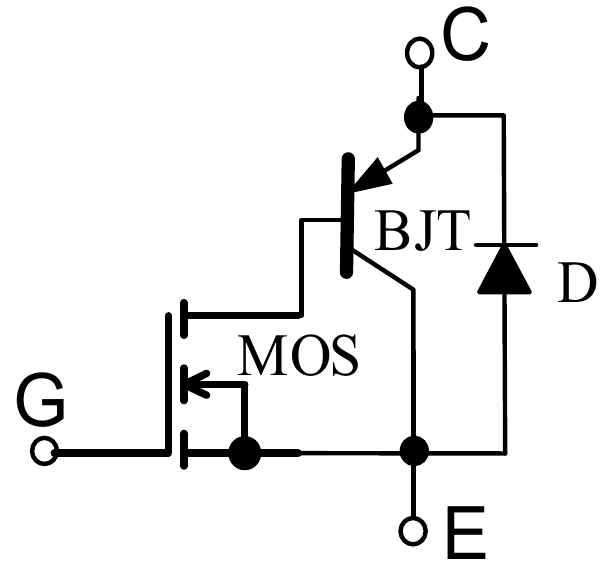
Figure 1. Network representation of the IGBT structure.